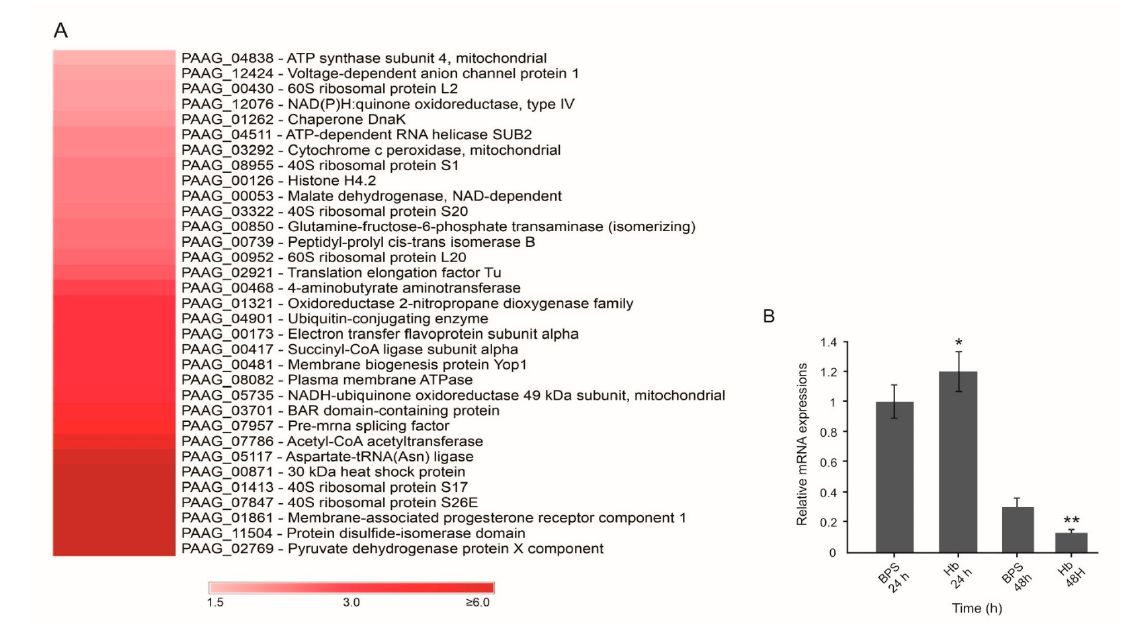
Figure 1. Heatmap of up-regulated proteins predicted as secreted and HSP30 transcriptional analysis. ( A ) The chart was generated using Microsoft Excel tools. Scale: ratio between Hb/BPS conditions. ( B ) HSP30 transcriptional analysis of WT strains of P. brasiliensis in the presence of hemoglobin. The yeast cells were grown in liquid Brain Heart Infusion (BHI) medium for 72 h and subsequently in McVeigh and Morton modified medium (MMcM) containing hemoglobin for 24 and 48 h. The control comprised cells grown in the presence of BPS under the same conditions. GraphPad Prism software (GraphPad Software, Inc., La Jolla, CA, USA) was used for the statistical analysis and Student’s t -test was applied considering p values ≤ 0.05 statistically significant. (*, **) denotes statistically significant differences.